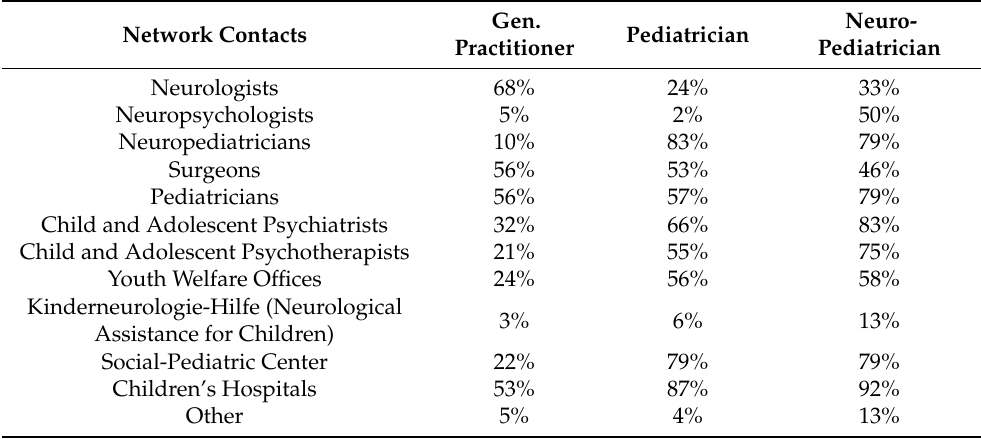
Table 3. Network contacts as stated by the different